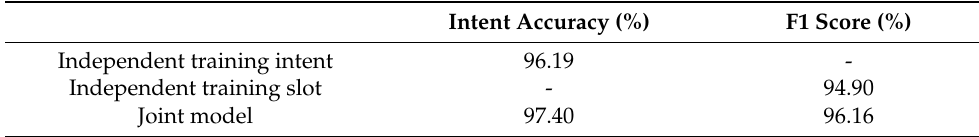
Table 3. Comparison of independent and joint models.